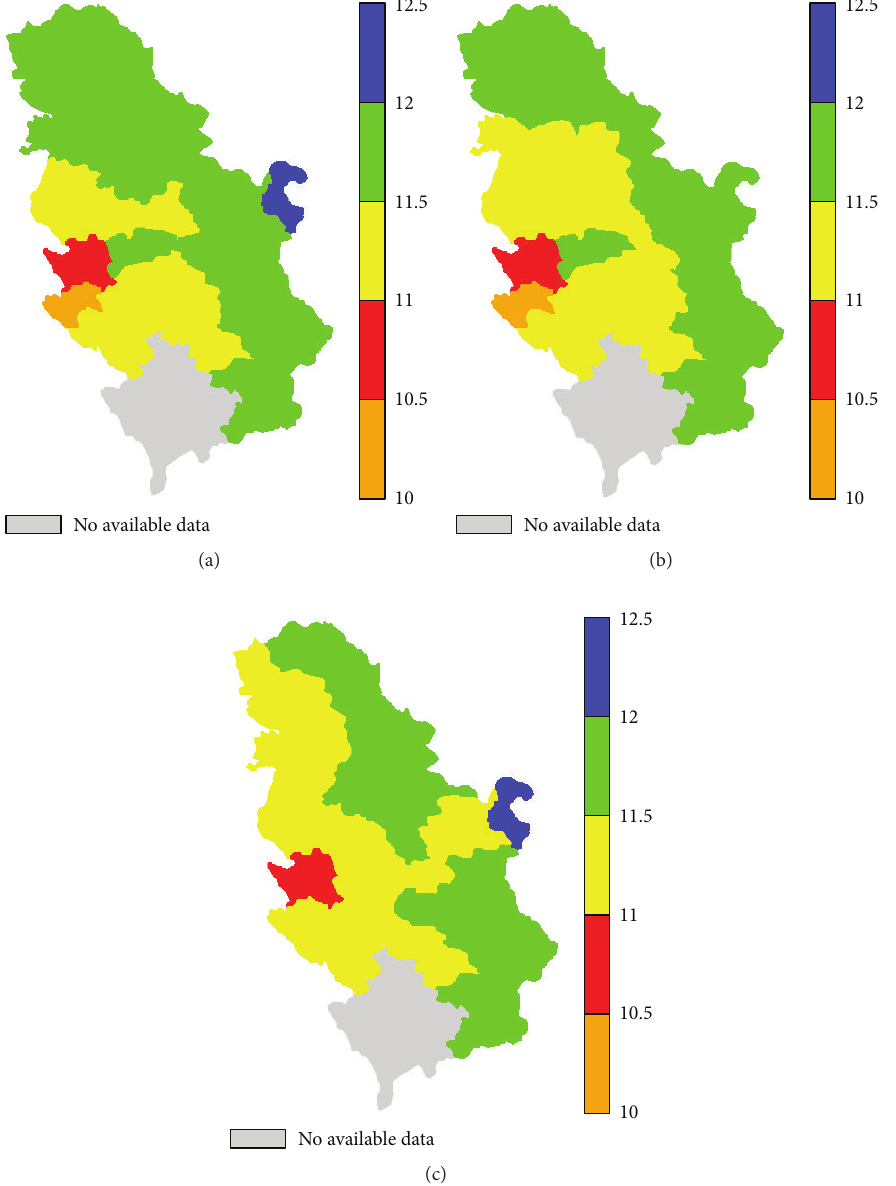
Figure 8: Spatial patterns of the PCI obtained using (a) SVM-Wavelet, (b) SVM-FFA, and (c) SVM-RBF